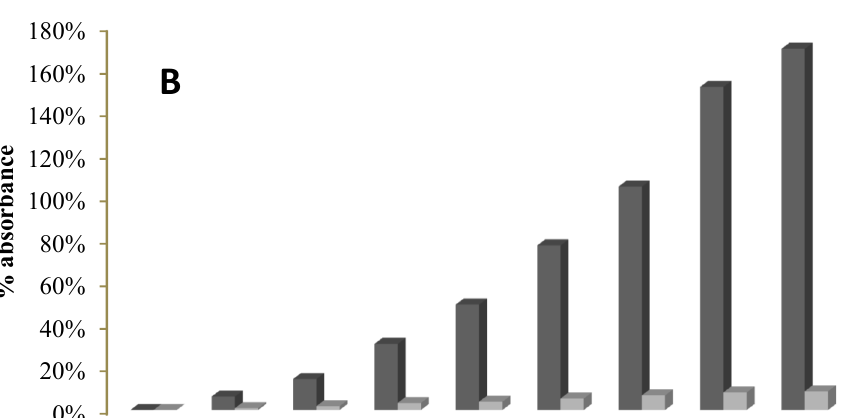
Figure 5. Evolution of absorbance in the UV-VIS spectra of 28.2 mM GA, at room temperature (A) and at 40 ° C (B), for 8 weeks. See also Figures S10–S13.